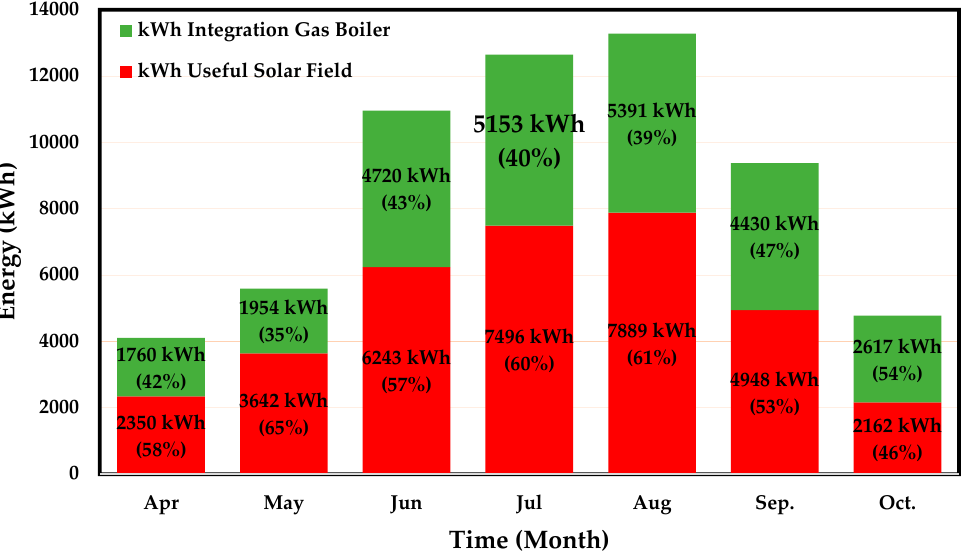
Figure 6. Energy contribution of integration gas boiler and solar field.